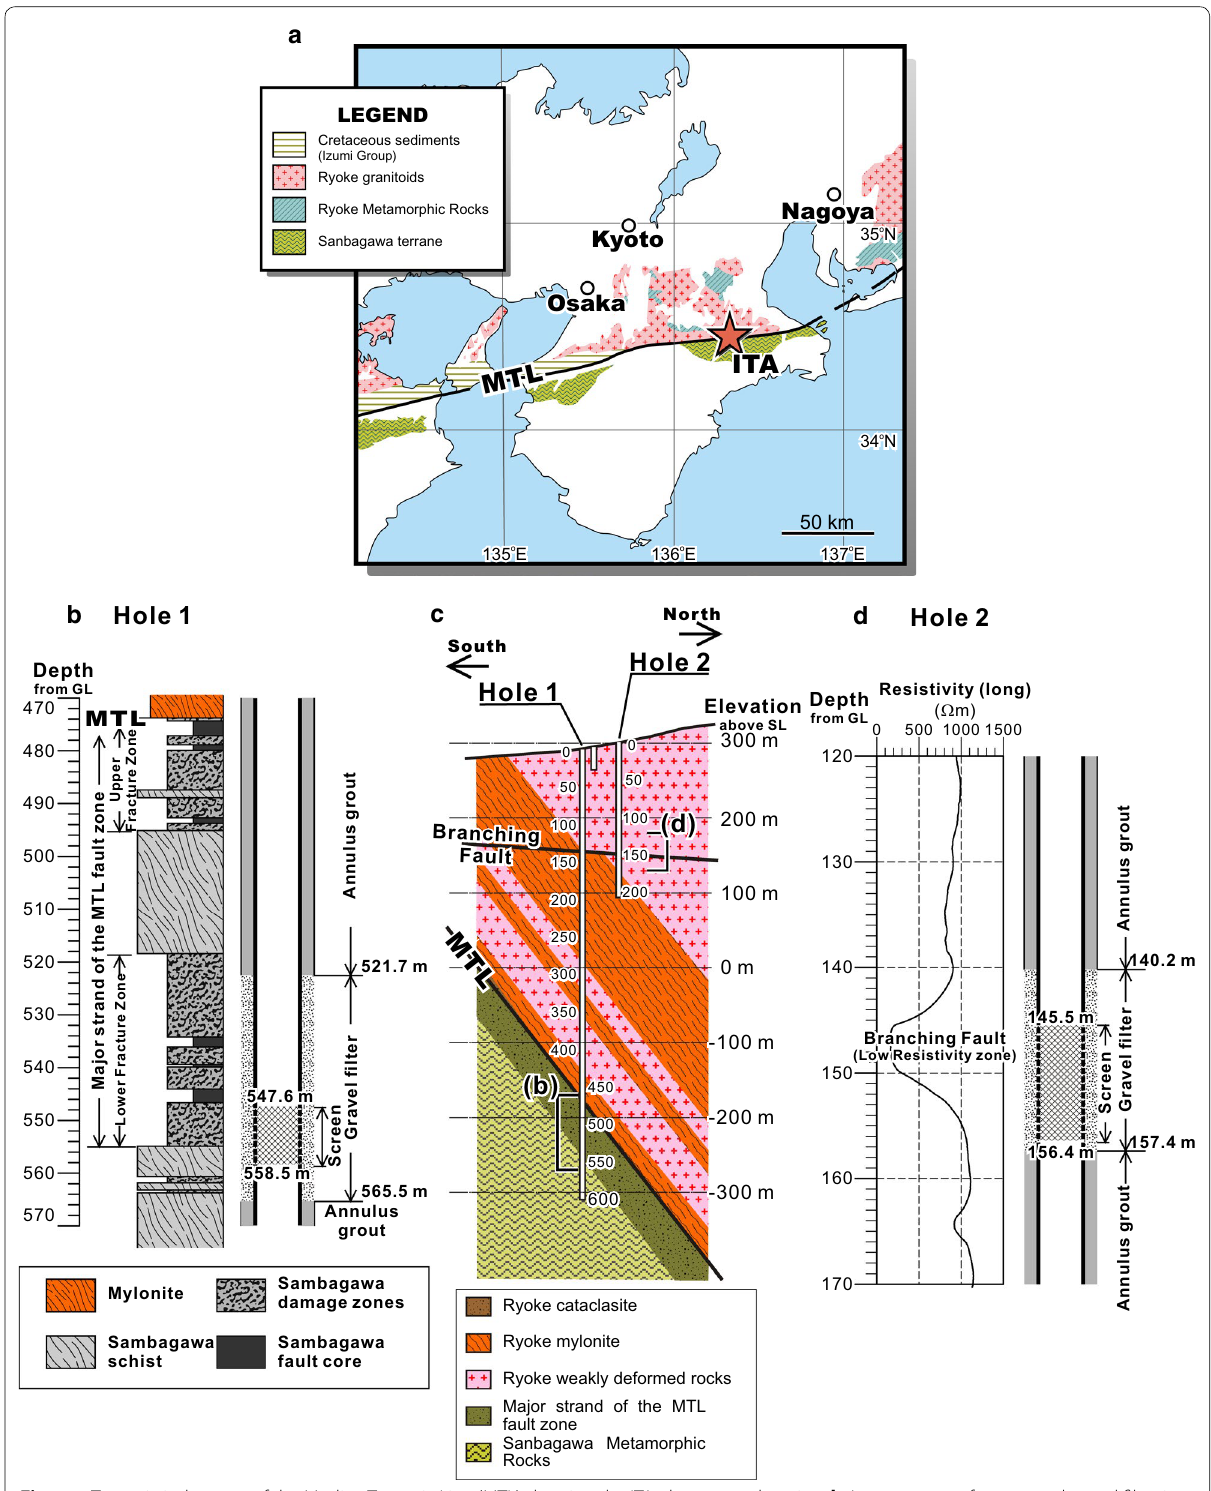
Fig. 1 a Tectonic index map of the Median Tectonic Line (MTL) showing the ITA observatory location. b Arrangement of screen and gravel filter in Hole 1 with a stratigraphic section showing the fault zone structure between 470 and 570 m deep. c Cross section of the ITA observatory showing the internal structure of the MTL fault zone. d Arrangement of screen and gravel filter in Hole 2 with the results of the resistivity